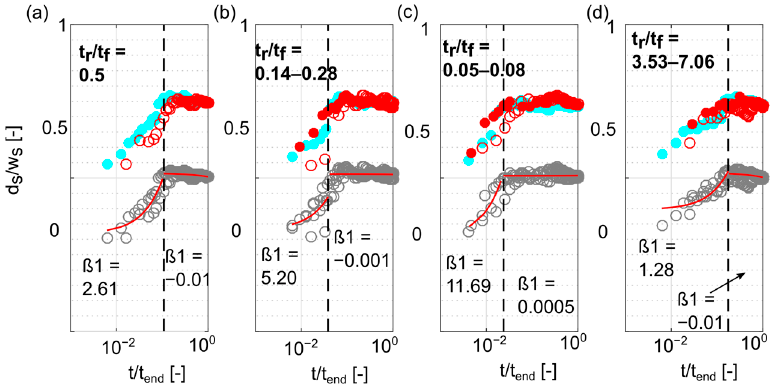
Figure 18. Geometrical relationship of d s /w s vs. nondimensional time in clear-water conditions and for different hydrograph shapes: ( a ) symmetrical, ( b ) positively skewed, ( c ) flash flood, and ( d ) negatively skewed.